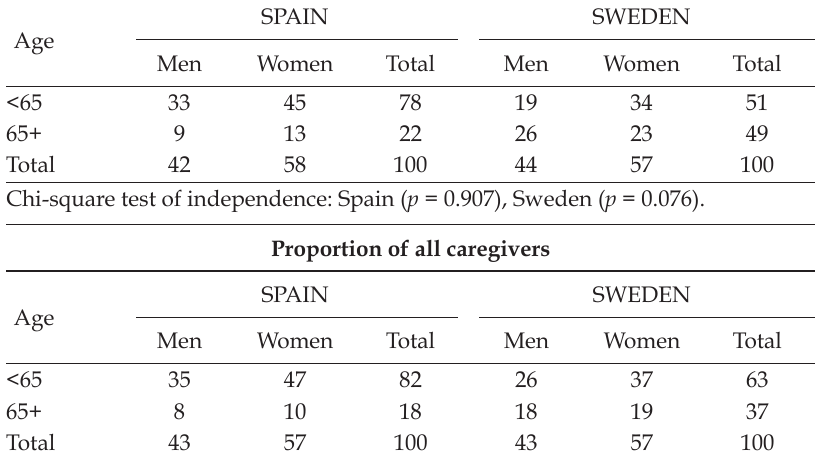
Sources: Our own computations on the UDP and ESUC surveys, using the re- striction on reported hours described in the footnote of Table